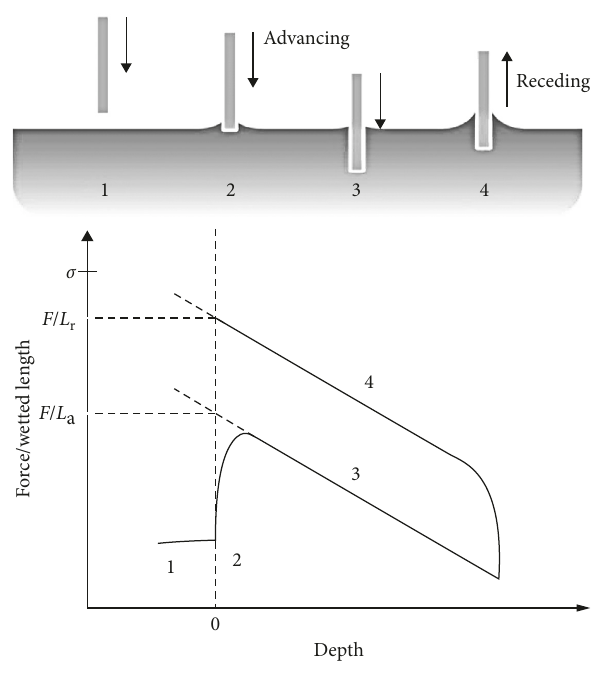
Figure 4: Schematic representation of the WPD method.